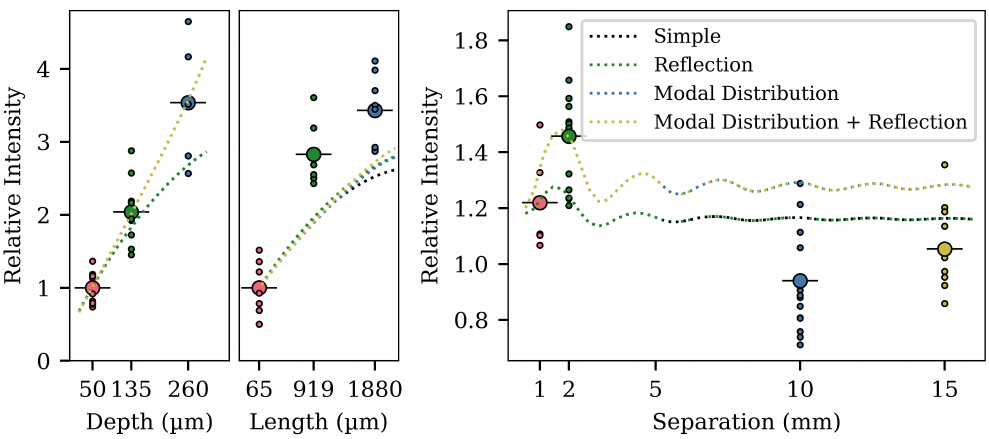
Figure 11. Simulation results with different combinations of effects added to the model. The intensity is relative to the intensity from a single cavity with the same geometrical parameters as either of the two annular cavities in the dual-cavity fibers ( l = 0.15mm and d = 125µm). The black dotted curve is the same model as used in Figures 5–7 and is the simplest model, with an excitation function of unity. The black curves are hidden behind the green curves on the left-most and right-most plots, as adding reflection only has minimal influence on the effect of separation. The same is true for the blue and yellow curves, where the blue is hidden behind the yellow in the left and right plots. The intensity at 2mm separation can also be quantified relative to a single cavity with double the length. In that case, the relative intensity is